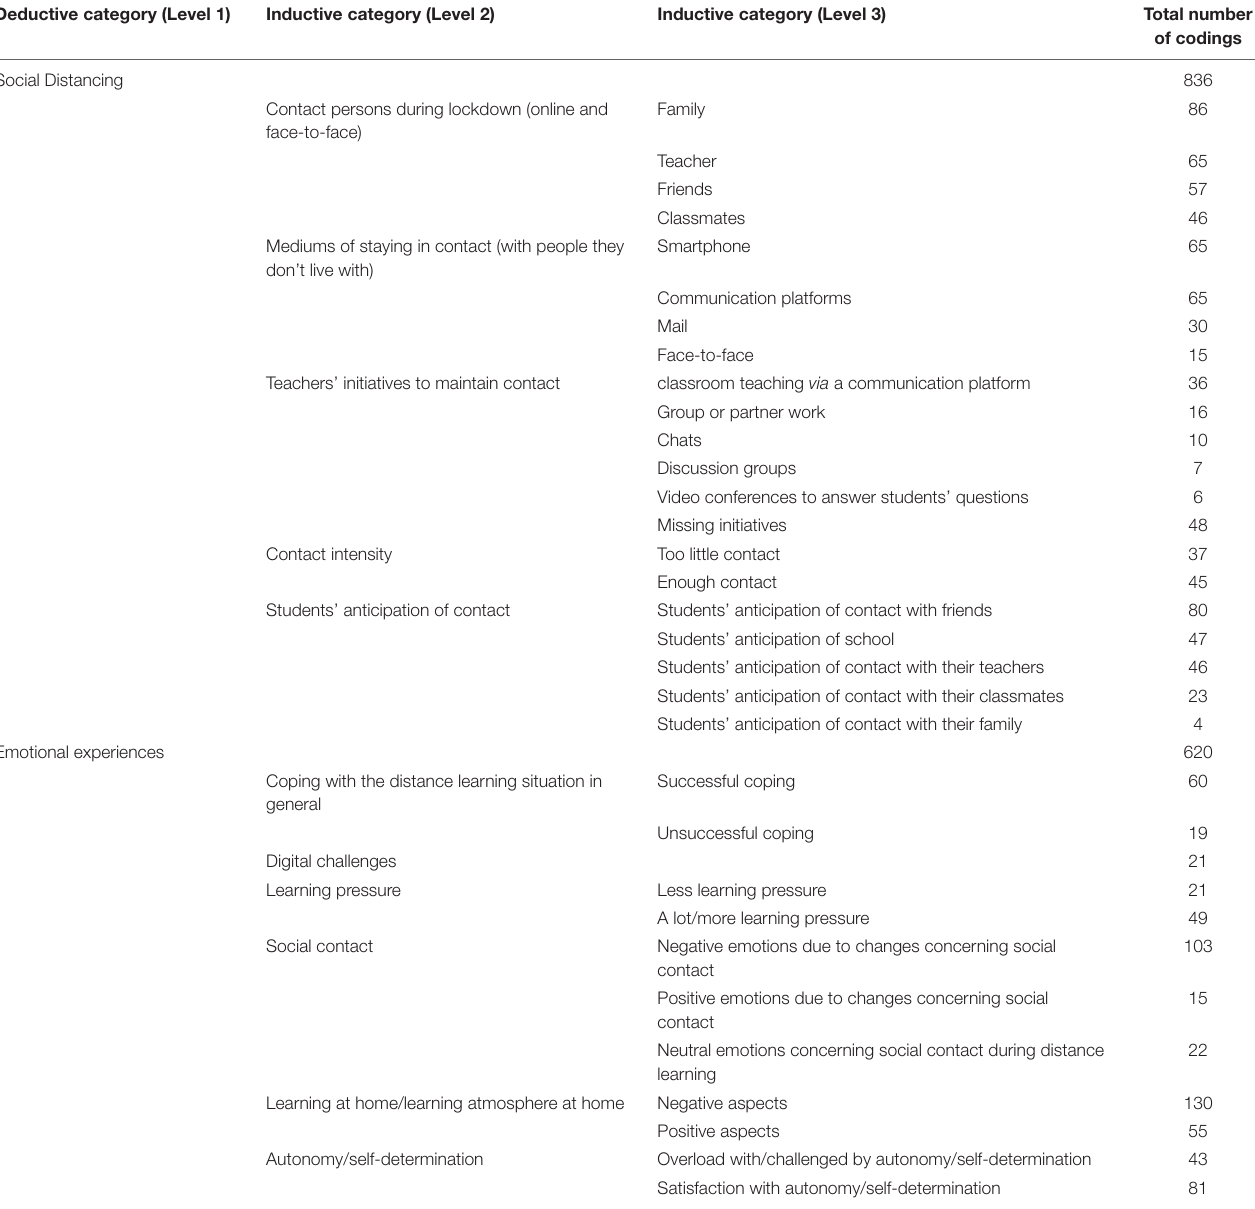
TABLE 6 | Total number of codings for each